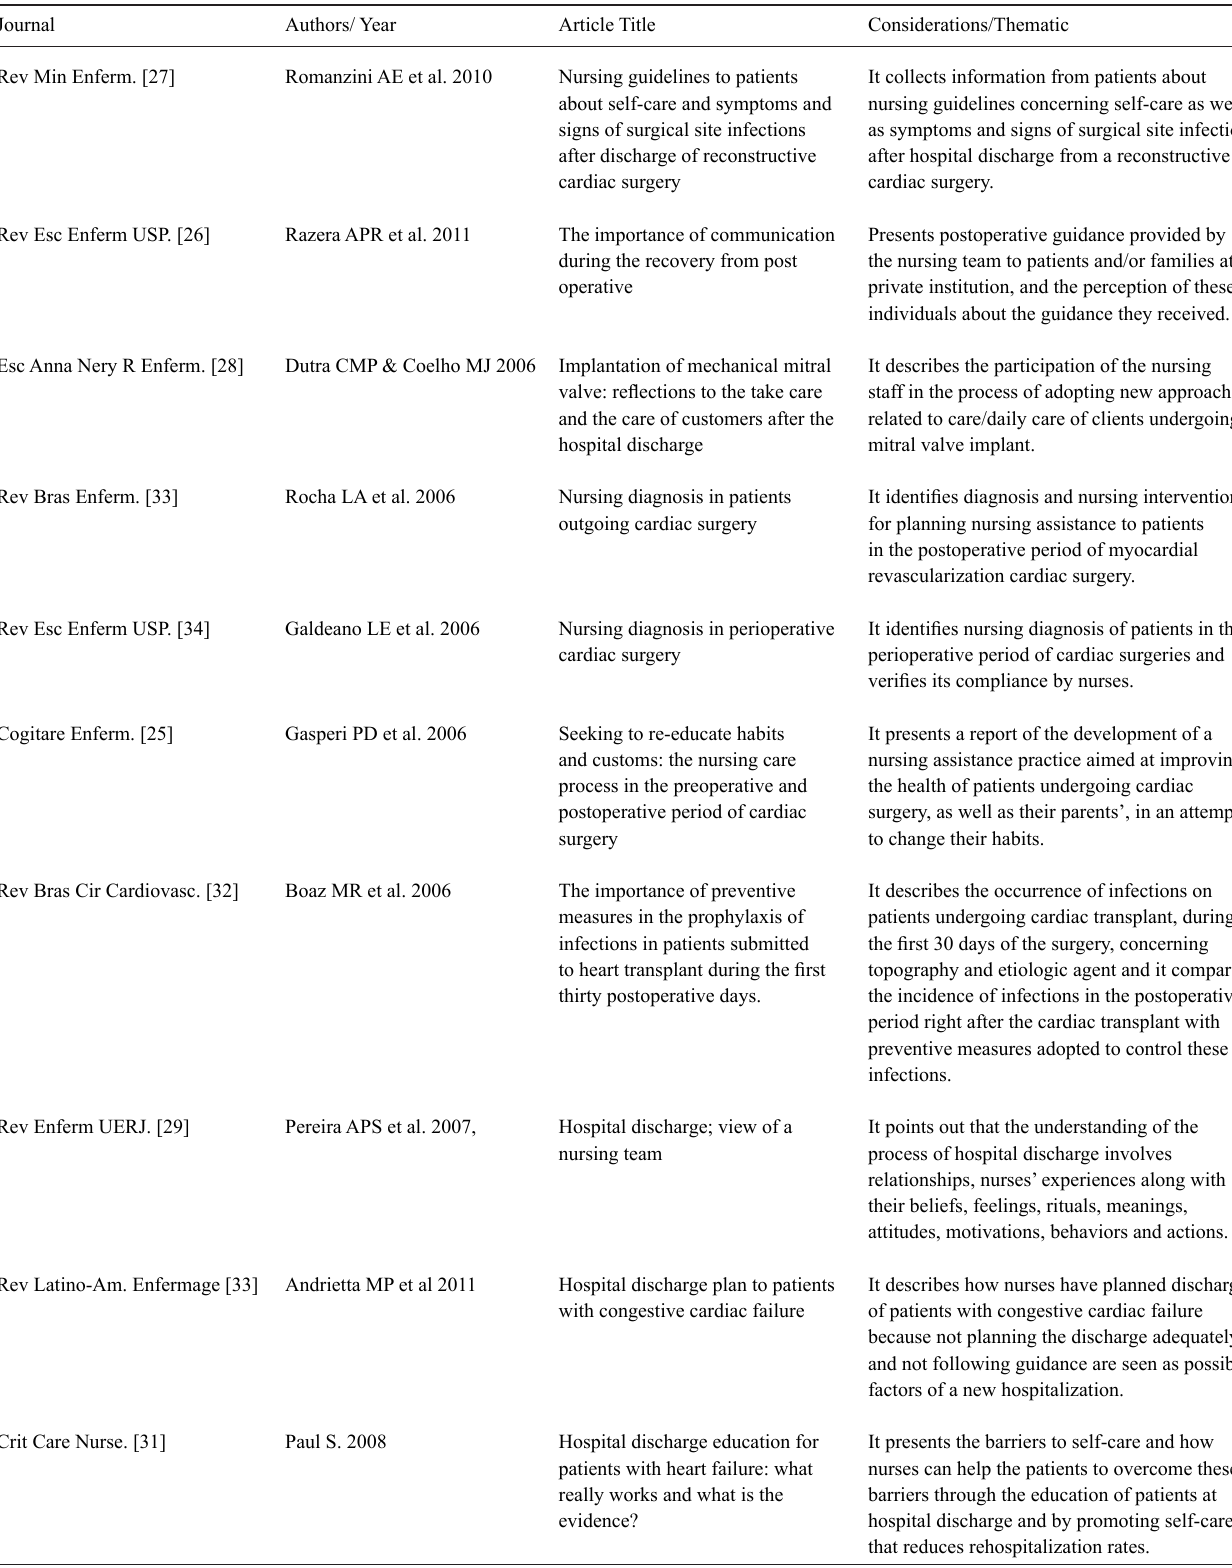
Table 1. Presentation of the synthesis of the articles selected for the integrative review.